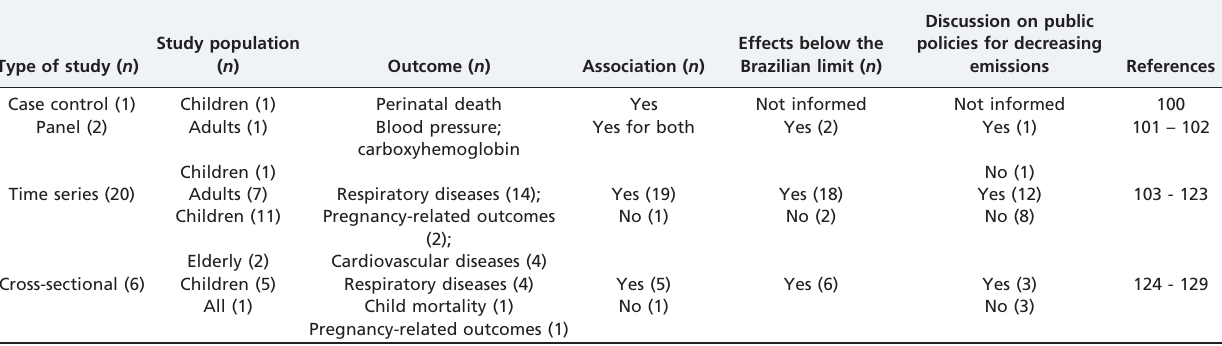
Table 2 - Brazilian studies of air pollution, categorized by type of study, study population, outcomes and effects found. Study population Type of study ( n ) ( n